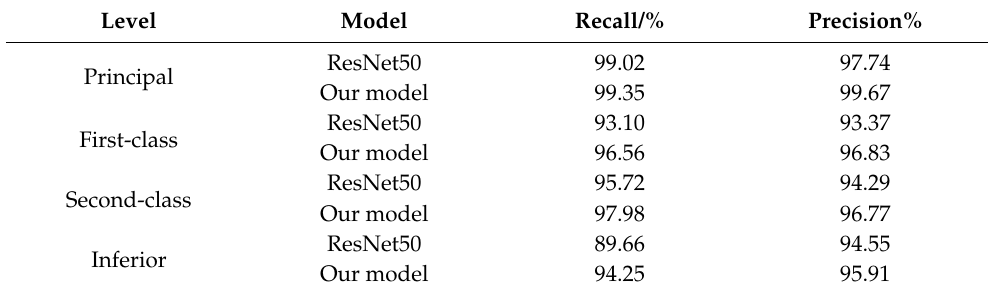
Table 8. Recall and accuracy of ginseng classification by class before and after model improvement.